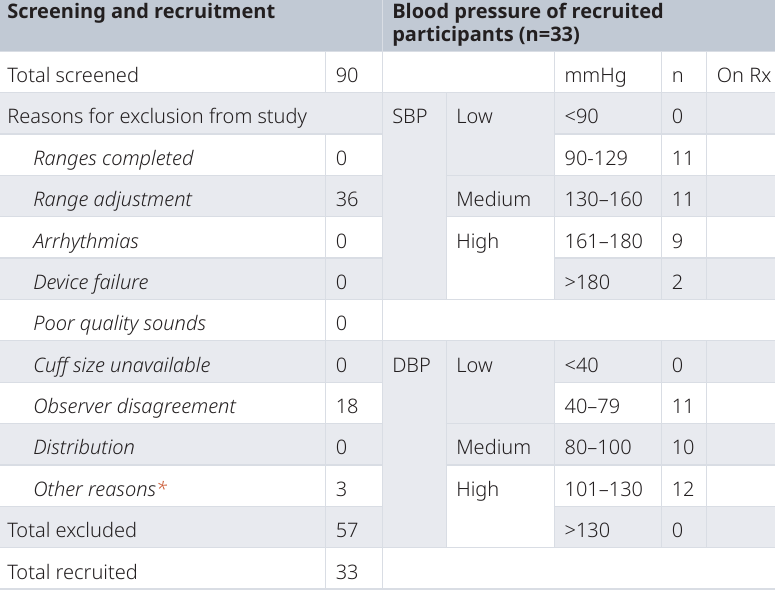
Table 1. Screening and recruitment details. Screening and recruitment Blood pressure of recruited participants